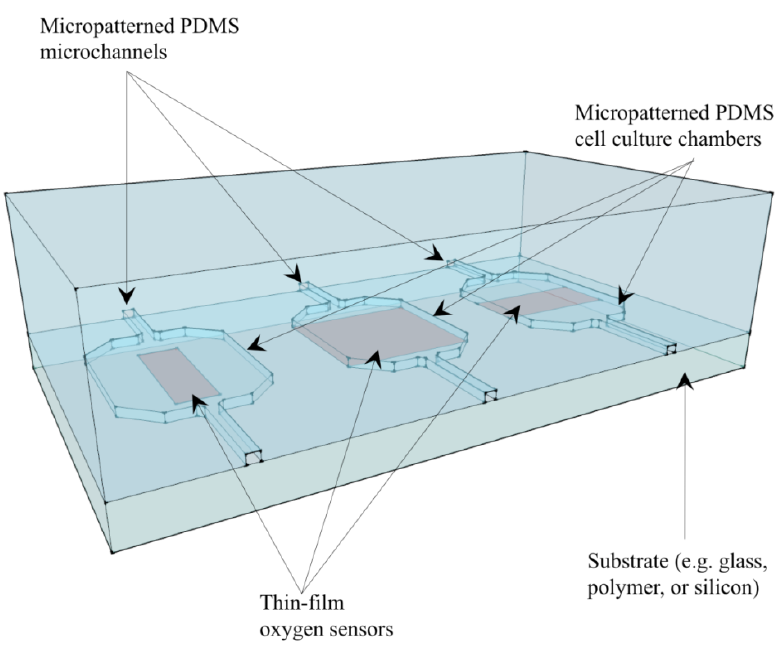
Figure 5. Illustration of enclosed PDMS microfluidic system for cell culture with possible designs for integrated optical oxygen sensors.